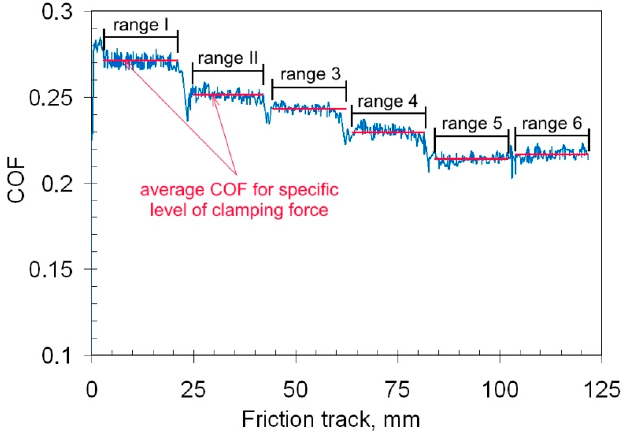
Figure 4. Variation of the coefficient of friction during the friction test with lubrication using L-AN 46 machine oil. 46 machine